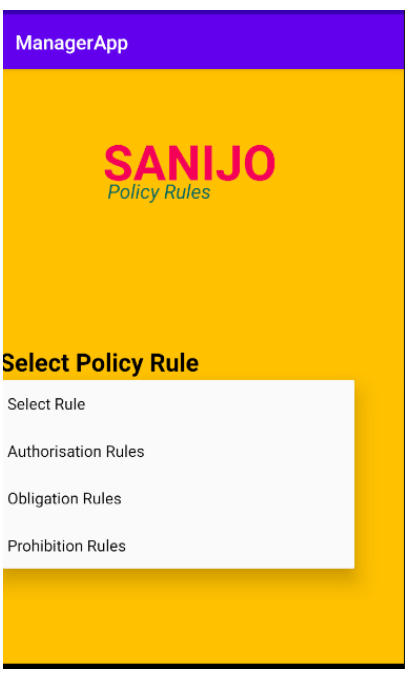
Figure 5. SANIJO Interface: Policy